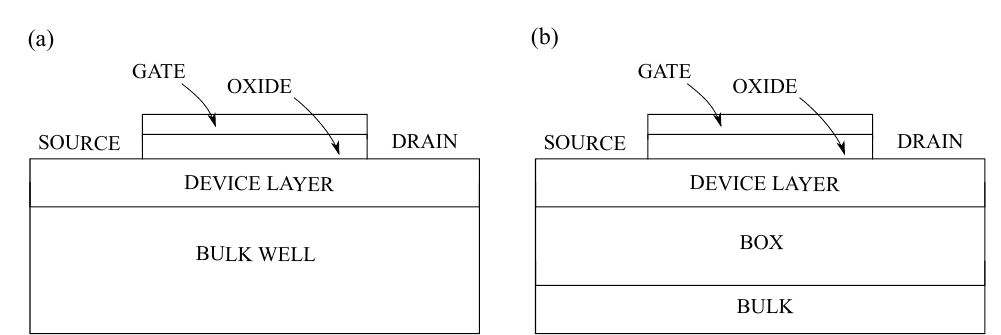
Figure 10. Cross-sectional view of a single gate junctionless transistor: ( a ) bulk, ( b ) SOI.